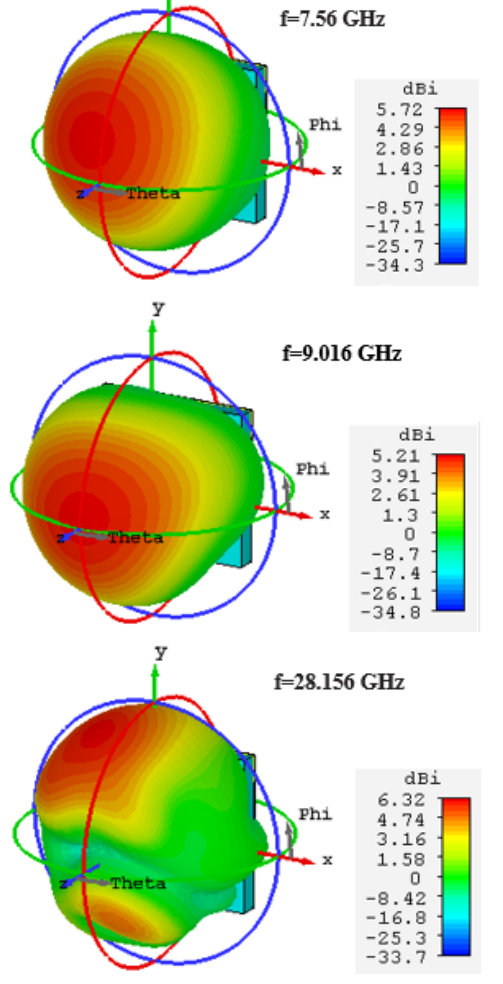
FIGURE 9. 3D radiation patterns of the proposed triple band antenna.